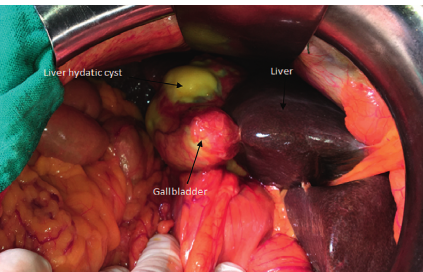
Figure 2: Operative image showing a hydatid cyst of segment IV adherent to the gallbladder.